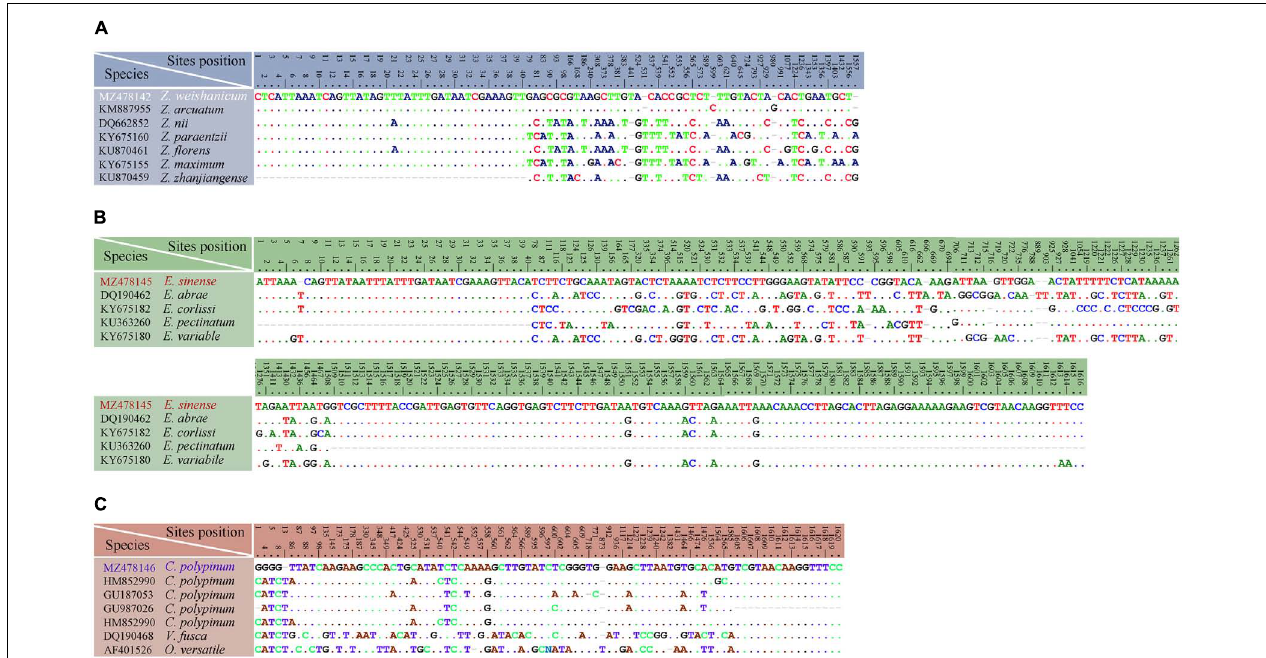
FIGURE 14 | Table of nucleotide variations based on SSU rDNA sequences. The numbers in the header indicate the unmatched site positions. (A) Zoothamnium weishanicum n. sp. with similar congeners. (B) Epicarchesium sinense n. sp. with similar congeners. (C) Carchesium polypinum (Qingdao population) with other populations and similar